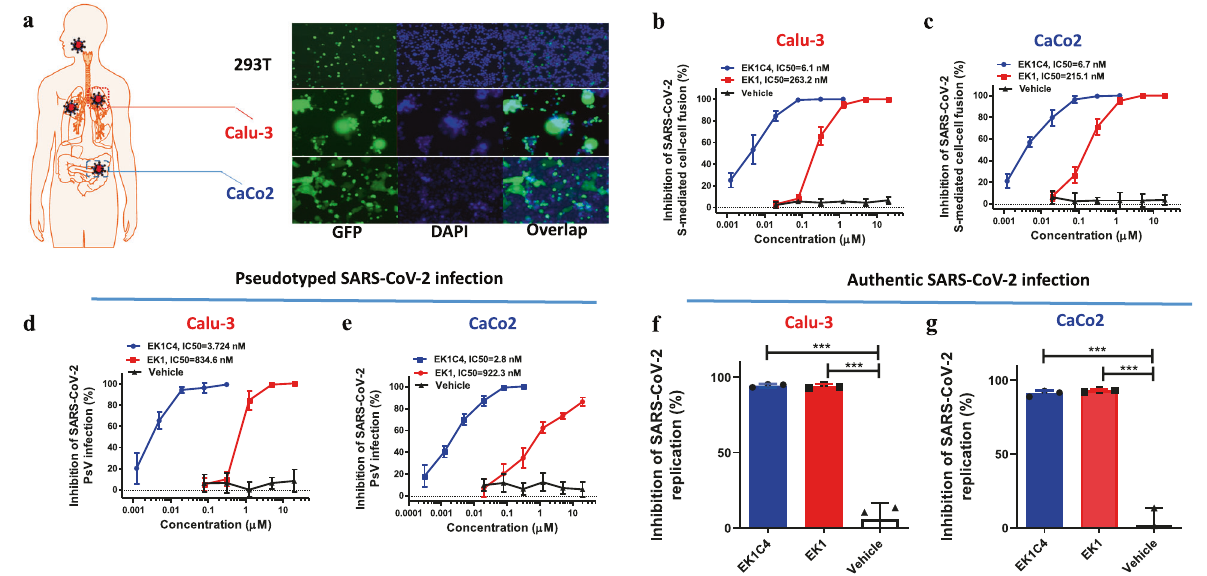
Fig. 1 Fusion inhibitory ef fi cacy of EK1 peptides against SARS-CoV-2 on Caco2 and Calu-3 cells. a The fusogenic capacity of SARS-CoV-2 S protein on, lung cell line, Calu-3 (middle) and human intestinal cell line, Caco2 (bottom), 293T cell line (upper) was used as control. b , c Fusion inhibitory activity of EK1 and EK1C4 against the SARS-CoV-2 S-mediated fusion process on Calu-3 ( b ) and Caco2 ( c ) cells. d , e Inhibitory activity of EK1 and EK1C4 against pseudotyped SARS-CoV-2 infection on Calu-3 ( d ) and Caco2 ( e ) cells. f , g Antiviral effect of EK1 (5 μ M) and EK1C4 (0.3 μ M) against authentic SARS-CoV-2 infection on Calu-3 ( f ) and Caco2 ( g ) cells. Viral supernatant was collected 48 h of post-infection and quanti fi ed by qRT-PCR. *** P <